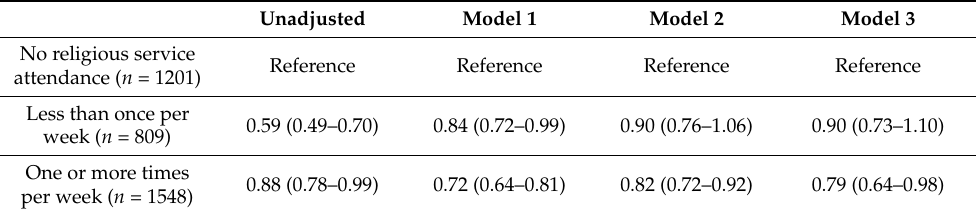
Table 3. Hazard ratios and 95% Confidence Intervals for the Association between All-Cause Mortality and Religious Service Attendance among NHANES III Participants with CKD.